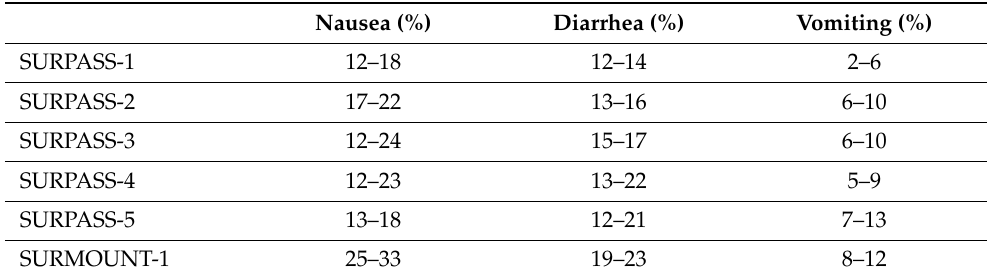
Table 7. Most commonly reported adverse events of Tirzepatide in clinical trials.